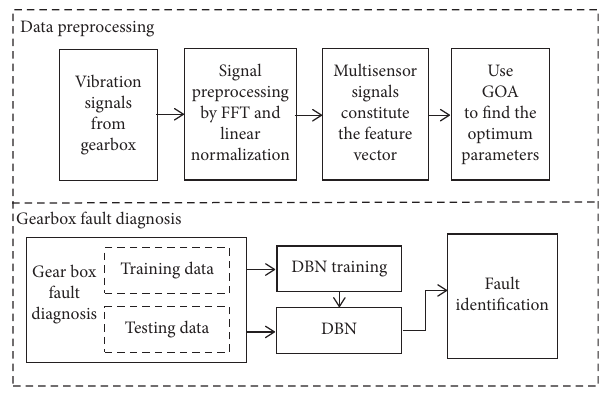
Figure 3: The flow chart of the proposed